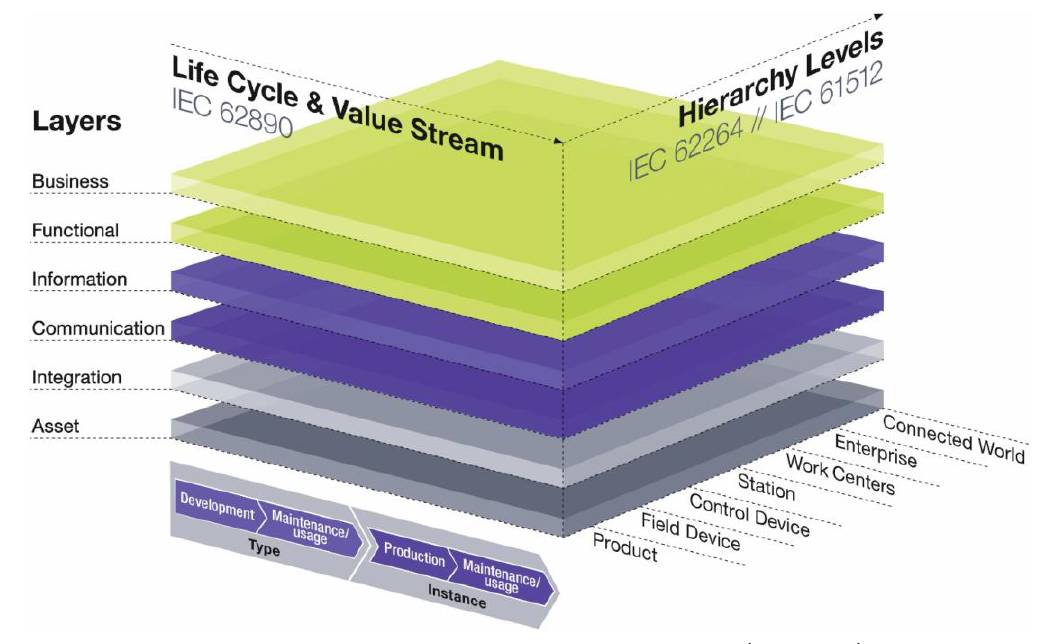
Figure 1. Reference architecture model Industry 4.0 (RAMI4.0)